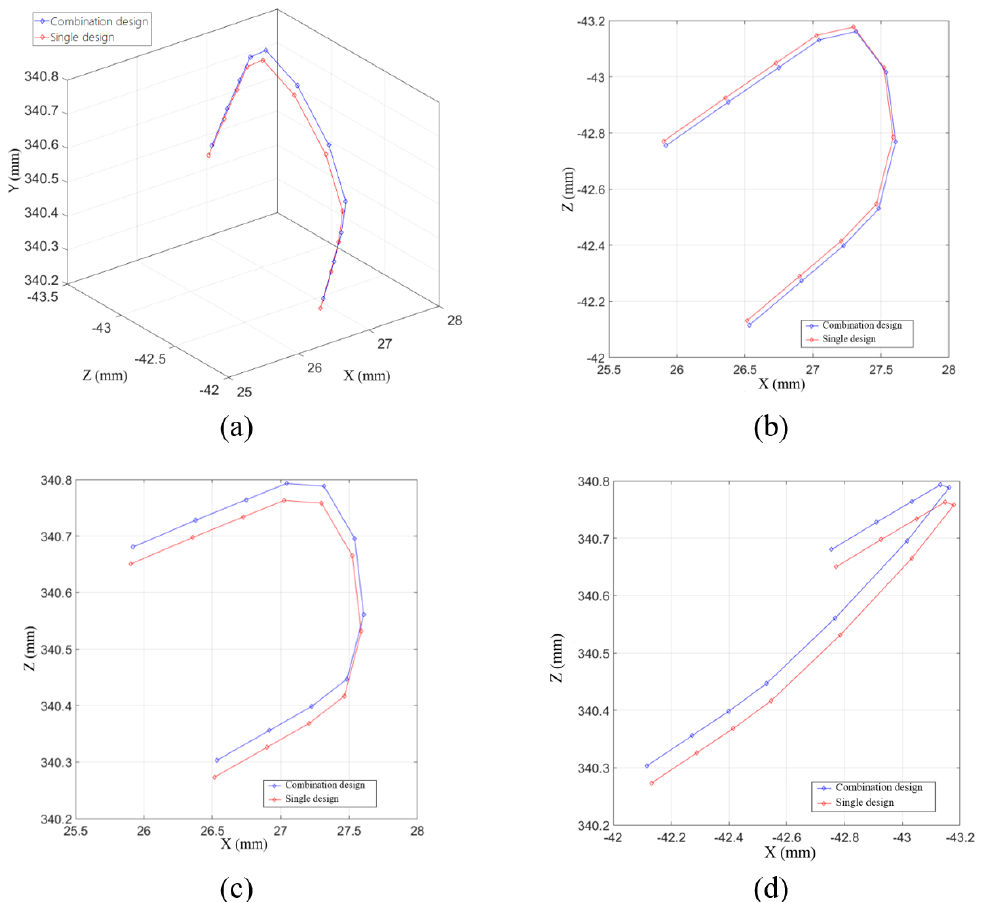
Figure 4. Comparison of the spatial position of the nodes at the trailing edge of the blade tip.